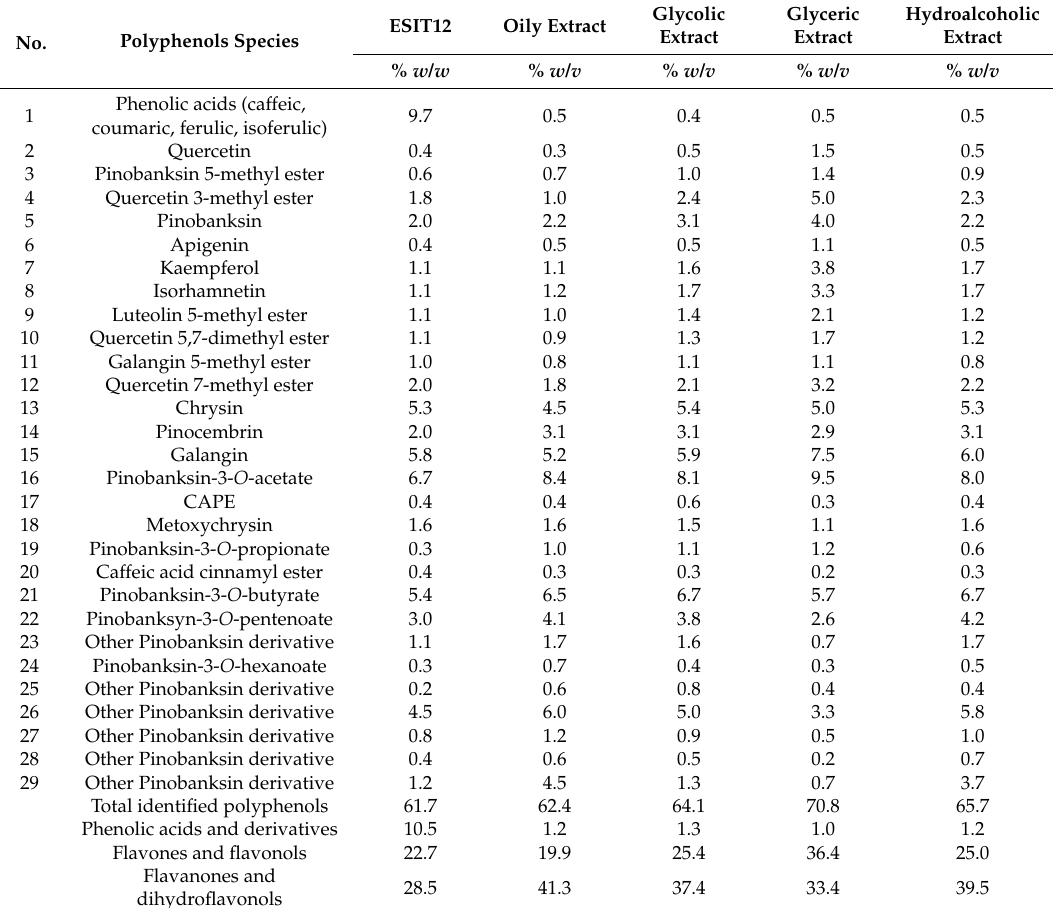
Table 1. Molecular composition of the various propolis preparations determined by high-performance liquid chromatography-UV-electrospray ionization mass (HPLC-UV-ESI-MS).